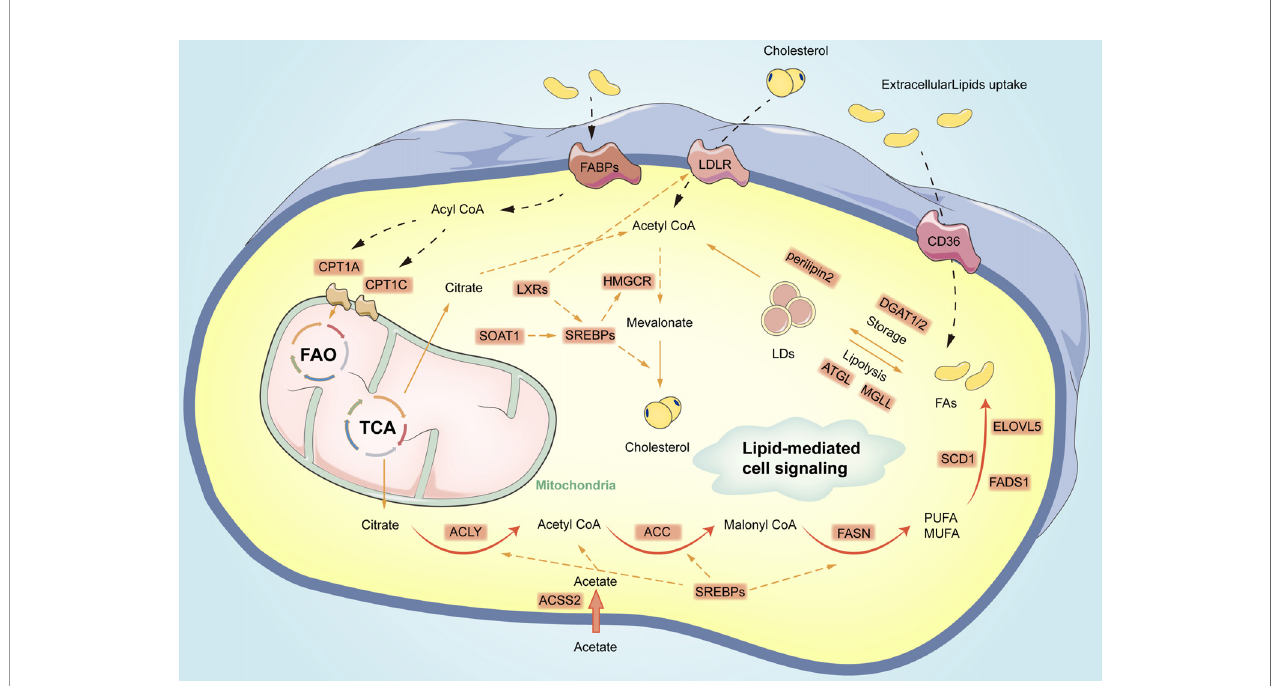
FIGURE 1 | Overview of fatty acid metabolism reprogramming in gastric cancer cells. The process primarily includes de novo lipid synthesis, fatty acid oxidation, cholesterol synthesis, formation, as well as lipolysis of lipid droplets. Orange circles represent vital enzymes in lipid metabolism pathways. CPT1, carnitine palmitoyl transferase 1; FAs, fatty acids; FAO, fatty acid oxidation; TCA, Tricarboxylic Acid; LDs, lipid droplets; MUFA, Mono-unsaturated fatty acids; PUFA, polyunsaturated fatty acids; DGAT1/2, diacylglycerol O-acyltransferases 2; ATGL, Adipose triglyceride lipase; MGLL, monoglyceride lipase; ELOVL5, elongation of very long-chain fatty acid protein 5; FADS1, fatty acid desaturase 1; SOAT1, Sterol O-acyltransferase 1; LXRs, Liver X receptors; CD36, Cluster of differentiation 36; LDLR, low- density lipoprotein receptor; FABPs, fatty acid-binding proteins; ACSS2, acetyl-CoA synthetase 2;CPT1A, carnitine acyltransferase 1 A; CPT1C, carnitine acyltransferase 1 C; ATGL, adipose triglyceride lipase; HSL, hormone-sensitive lipase; MGLL, monoglyceride